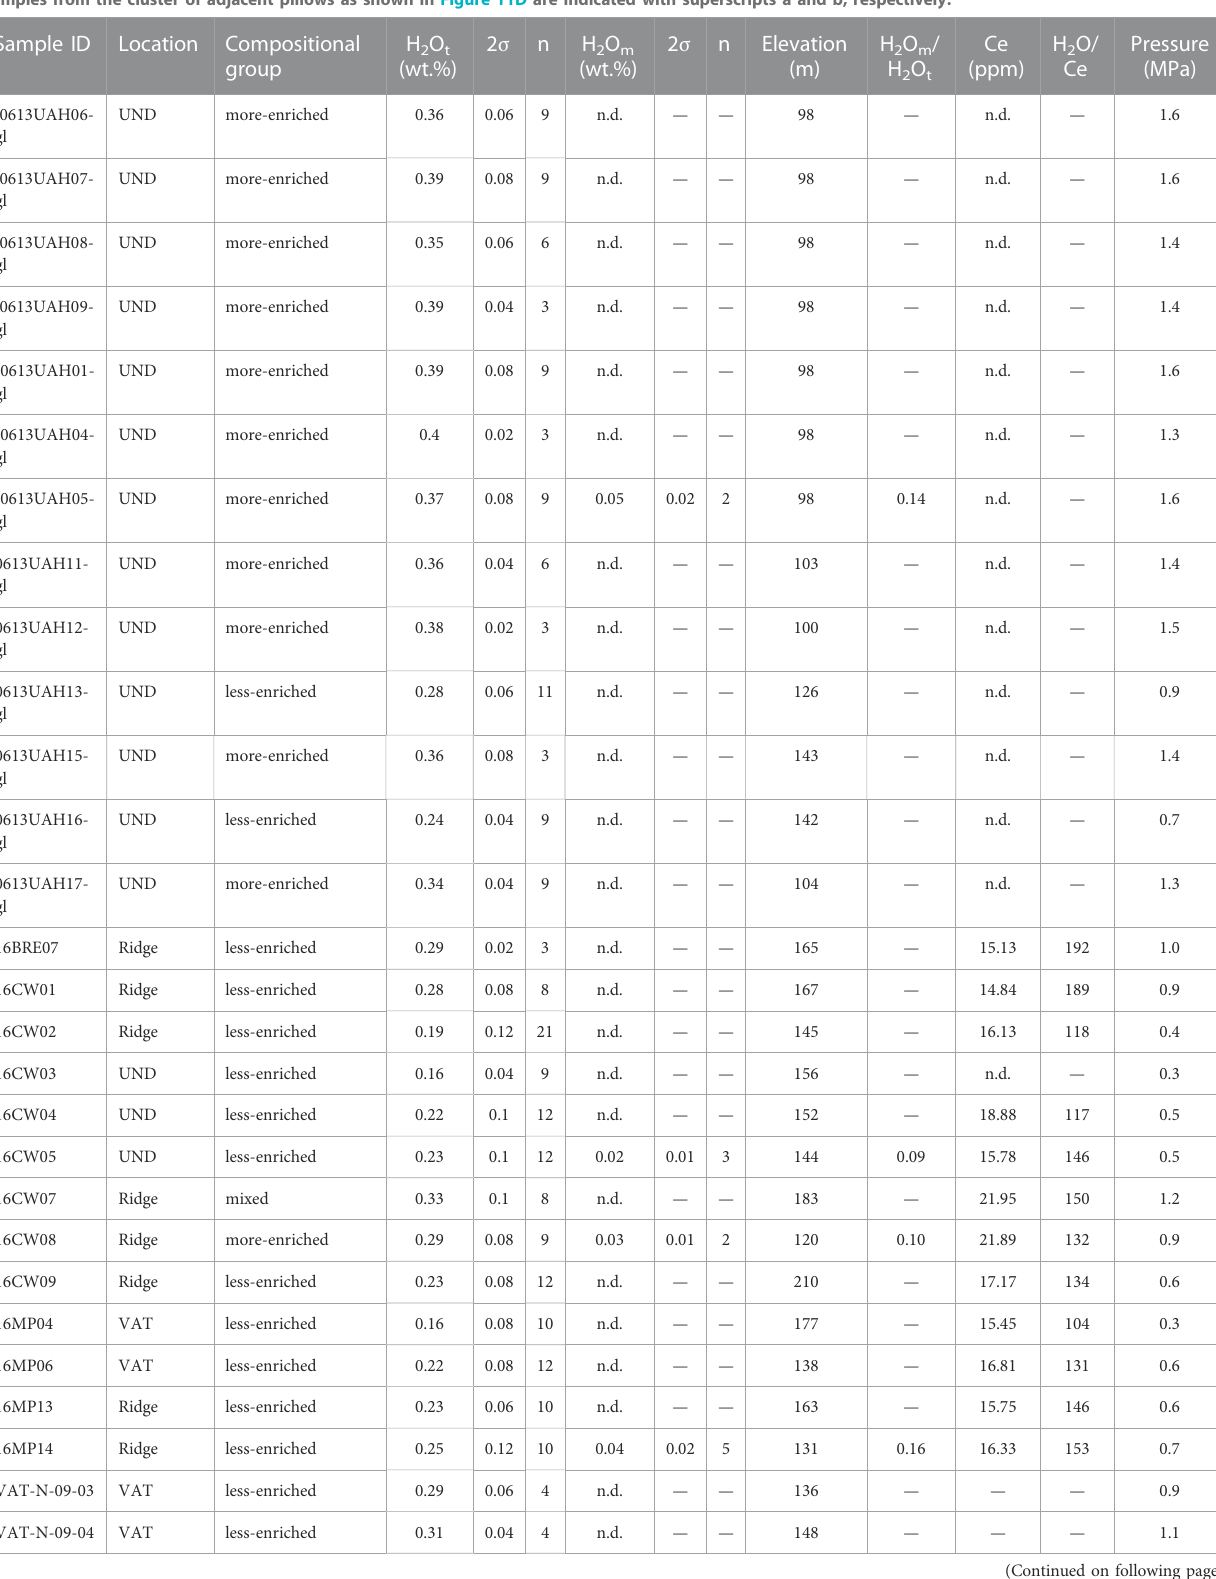
TABLE 3 Water contents, elevations, and saturation pressures of Undirhlíðar ridge samples. Location describes sample sites in Undirhlíðar quarry (UND), Vatnsskarð quarry (VAT), or along the ridge between the quarries. Compositional group de fi ned by La N /Sm N value as described in the text. H 2 O t and H 2 O m concentrations(inwt.%)arecalculated averages ofnnumberof FTIRspectra.Erroris2 σ standard deviation ofuncertaintypropagatedthrough theBeer-Lambert Law. n.d. indicates values that were not determined. Elevations (in m) determined from a digital elevation model as described in the text. Ce (in ppm) determined on whole-rock samples.Pressure (in MPa) is H 2 O saturation pressure calculated using VolatileCalc (v. 2.0) assuming complete CO 2 degassing (i.e., CO 2 = 0 ppm) as described in text. Full compositional data and pressure calculations are available in Supplementary Material. Four samples from the same pillow lava and seven samples from the cluster of adjacent pillows as shown in Figure 11D are indicated with superscripts a and b,